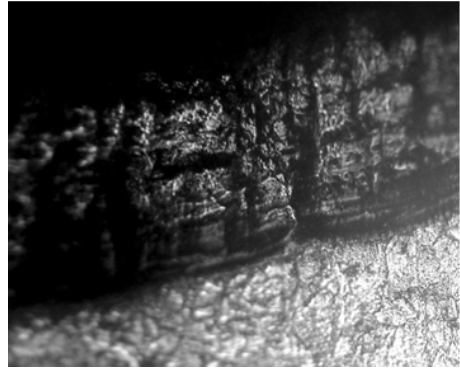
Figure 8: Micrographic analysis. Under site of large pit surface. Presence of infiltration that give birth to new pits. – 200 X.